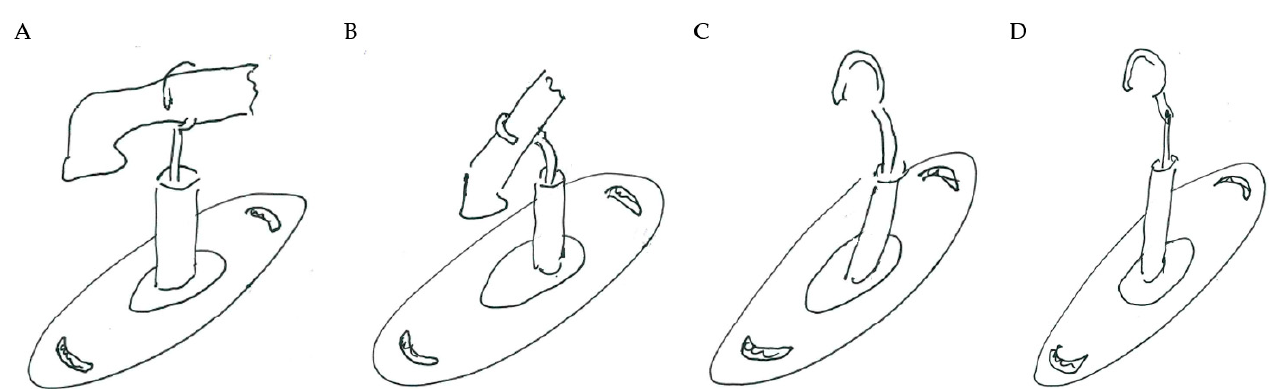
Figure 3. The visualization of stapes prosthesis problematics: ideal case study, problematics, and solution. ( A ) ideal/target placement of stapes prosthesis, ( B ) real placement of incus long process in respect of prosthesis (or obtained long-term after the operation), ( C ) view of prosthesis that has lost stability and is leaning not with the surface of the piston, ( D ) solution to achieve and retain the stapes prosthesis stability: prosthesis with the joint (adjustable angled prosthesis).